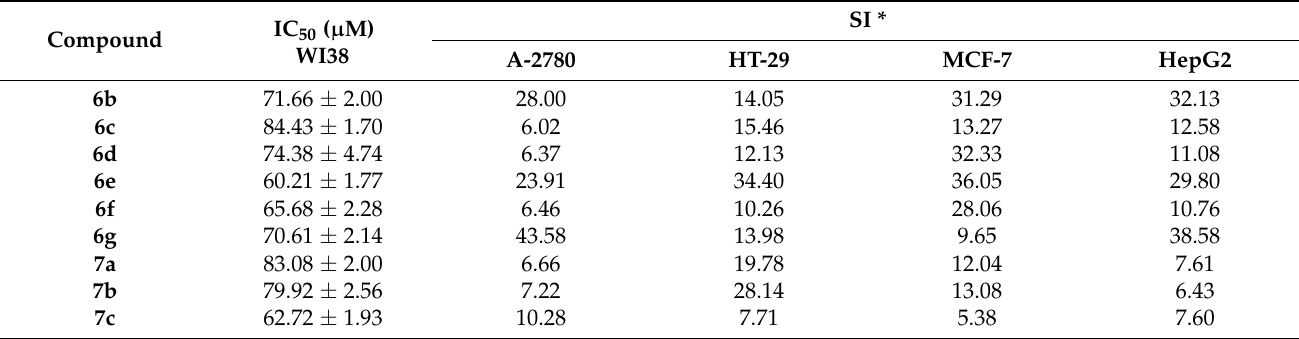
Table 2. Cytotoxic activity of compounds 6b–g and 7a–c against WI38 normal cells and their